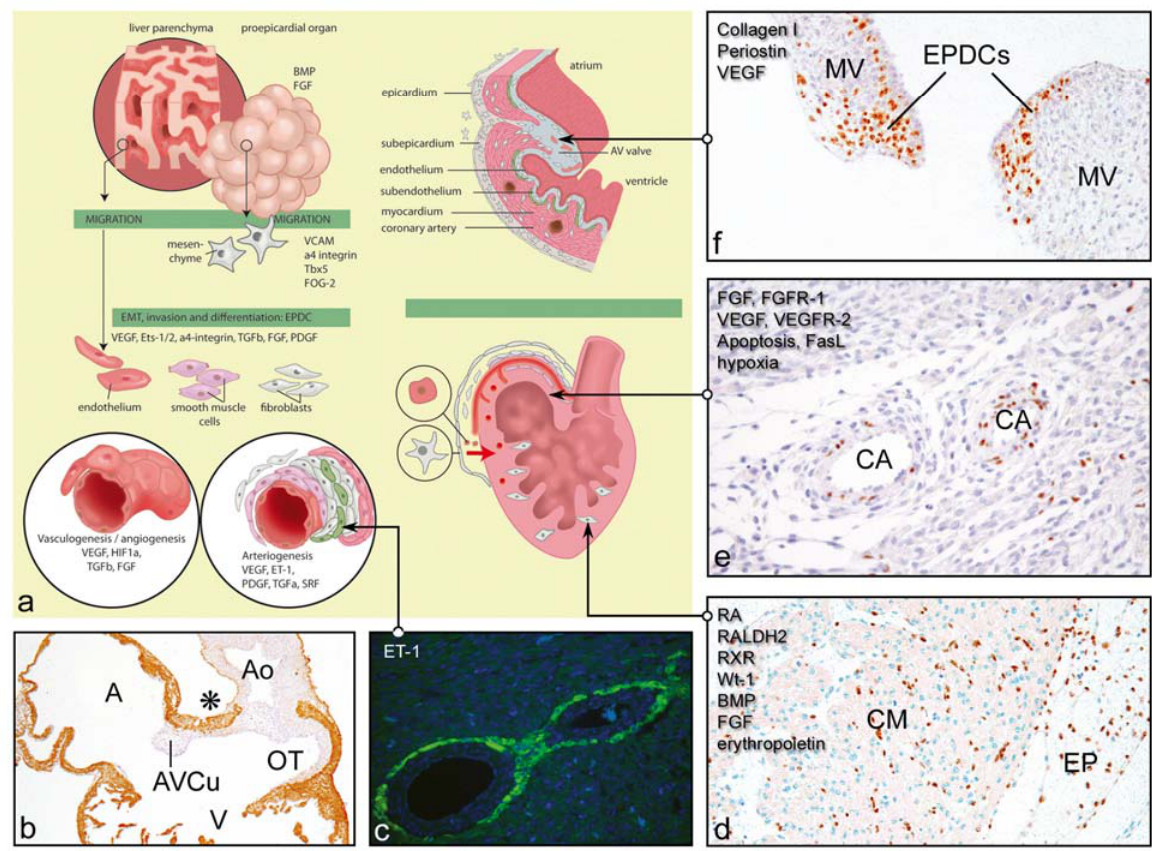
FIGURE 3. Schematic figure of EPDC fate and function. (a) Together with the development of the PEO, endothelial precursor cells of the liver region travel along with the proepicardial cells to the naked heart tube. After migration and epithelial-mesenchymal transformation of the epicardium, the subepicardial mesenchyme is formed, and EPDCs start to migrate into the underlying myocardium (a,f) where they differentiate into SMCs and fibroblasts. Counterclockwise, the photomicrographs (b–f) indicate their migratory fates and functions. Factors known to be involved in these developmental processes are listed in the left upper corner of the photomicrographs (for references, see text). (b) Migration into the myocardium starts in the inner curvature, where EPDCs may well have a function in the late looping process. This photomicrograph shows a far-too-wide inner curvature after mechanical ablation of the PEO ([43], used with permission from the authors). (c) EPDCs induce the formation of the peripheral conduction system; Purkinje fibers, shown here after immunofluorescent staining with the EAP- 300 antibody, will not develop properly in epicardially inhibited embryos ([71], used with permission from the authors). (d) In a proepicardial quail-chicken chimera, tracing with the quail-specific nuclear marker QCPN reveals that a large proportion of the cells of the ventricular myocardial walls are EPDCs ([69], used with permission from the authors). Here, they contribute to myocardial architecture by expression of procollagen I and the extracellular matrix protein periostin (for references see text). (e) This photomicrograph of a quail-chicken chimera demonstrates that in the coronary arteries, EPDCs constitute the SMCs and fibroblasts that stabilize the vessel walls. (f) In the developing atrioventricular valves, many of the fibroblasts in the valve leaflets are epicardium derived, as is shown in this section of a proepicardial quail- chicken chimera ([69], used with permission from the authors). A, atrium; Ao, aorta; AVCu, atrioventricular cushion; CA, coronary artery; CM, myocardium; EP, (sub)epicardium; MV, mitral valve; V,